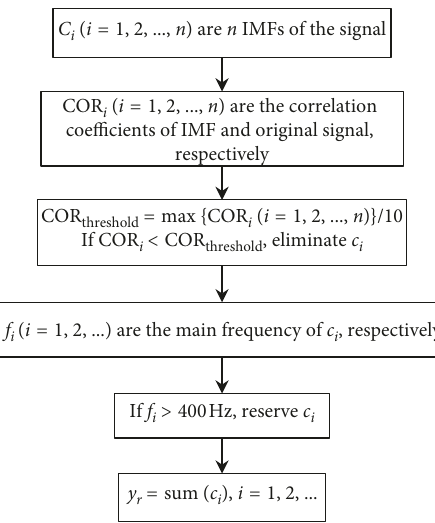
Figure 10: IMFs selection and signal reconstruction